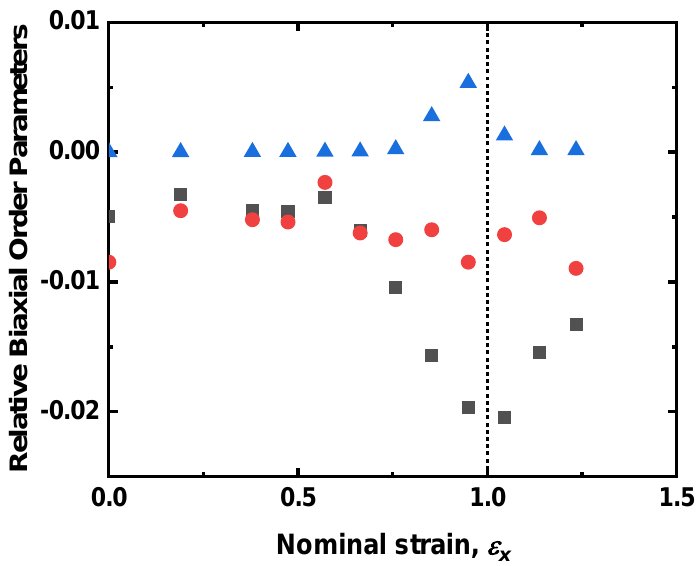
Figure 8. The biaxial order parameters ⟨P 220 ⟩ (grey squares), ⟨P 420 ⟩ (red circles) and ⟨P 440 ⟩ (blue triangles) as a function of strain. The dotted line denotes where the maximum value of ⟨P 440 ⟩ is seen, a point that coincides with the MFT of this material.